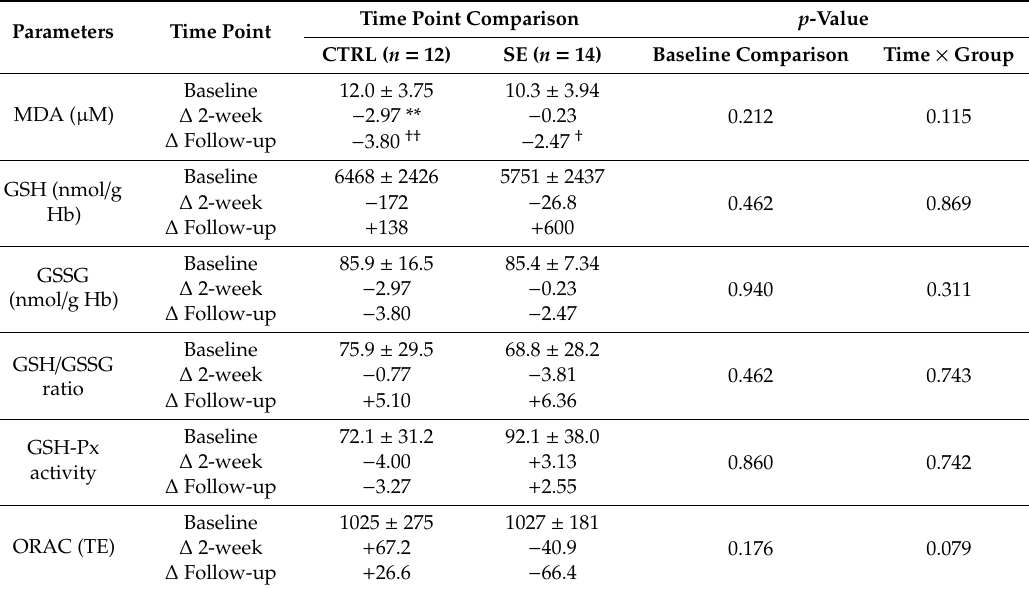
Table 3. Changes in oxidative stress parameter values following